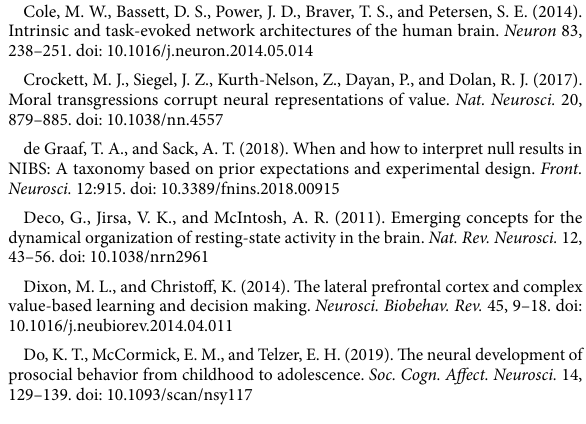
SUPPLEMENTARY FIGURE S1 Negative Findings. We show the results from the Network-Based Statistic (NBS) with resting state connectivity related to (A) the CEASY questionnaire alone and (B & C) the SDQ questionnaire alone. All these results were non-significant at the test-statistic threshold 2.75. Network number of edges, nodes, and NBS-corrected p-values are displayed in the bottom right panel of each network. Note that both the networks in (A) and (C) contain a highly overlapping precuneus centered module, with the right precuneus highlighted in